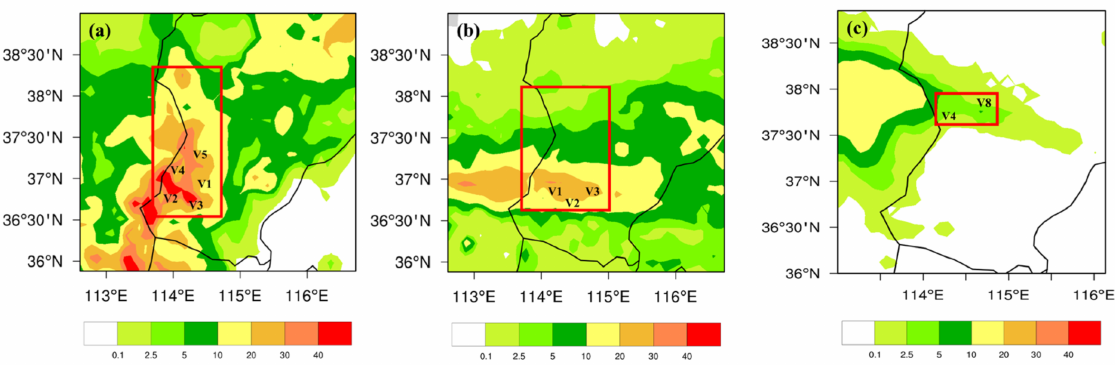
Figure 2. Cumulative precipitation: ( a ) is for 22 May 2017, ( b ) is for 21 May 2018, and ( c ) is for 24 August 2019.